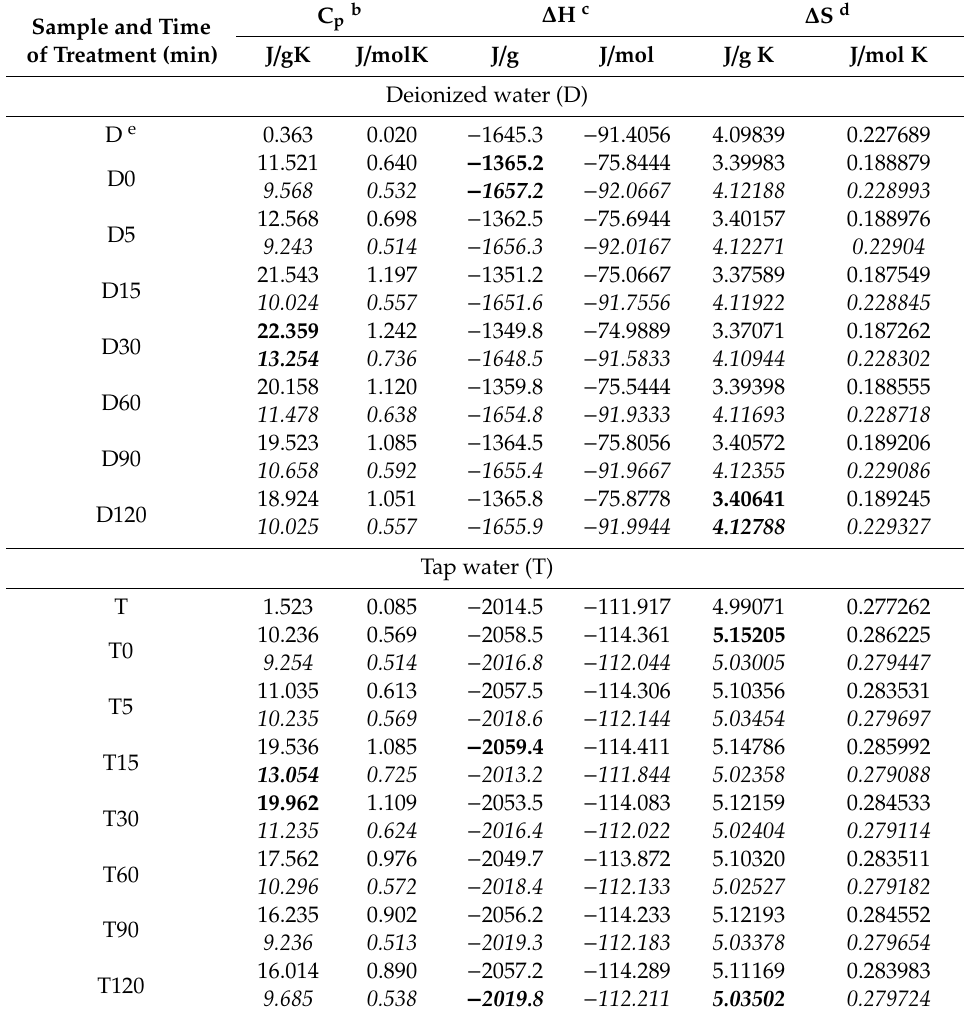
Table 9. Thermodynamic data of deionized (D) and tap (T) water treated with LPGP a related to water mass and water molecular